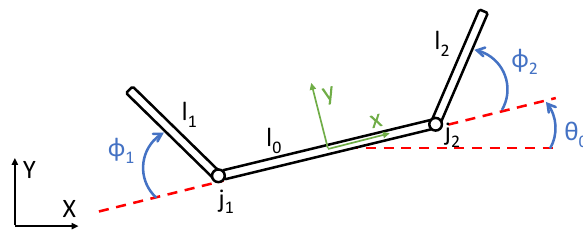
Figure 3. General scheme of the Purcell’s three-link